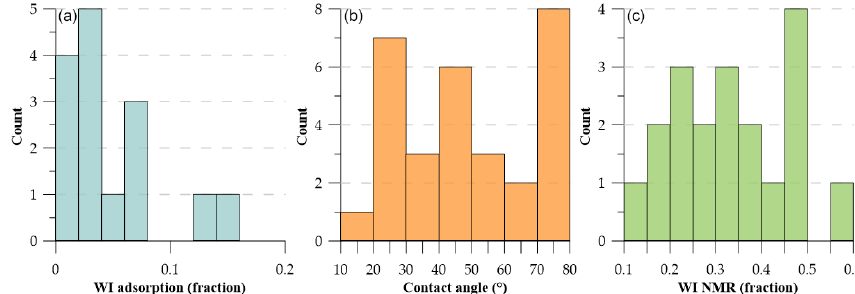
Figure 3. Results of wettability determination by (a) vapor adsorption, (b) contact angle method and (c)